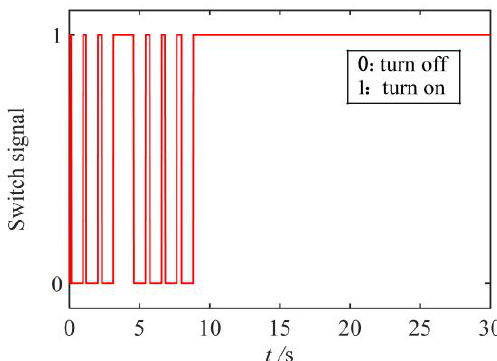
Figure 12. Switch signal of motor (F C2 = 80 N · m, F O2 = 10 N · m).